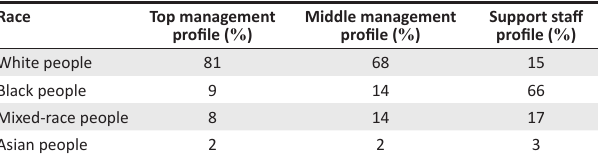
TABLE 3: Percentage of top management. TABLE 2: Top management profile, middle management profile and support staff profile. Variable Race Top management Middle management Support staff profile ( % ) profile ( % ) profile ( %